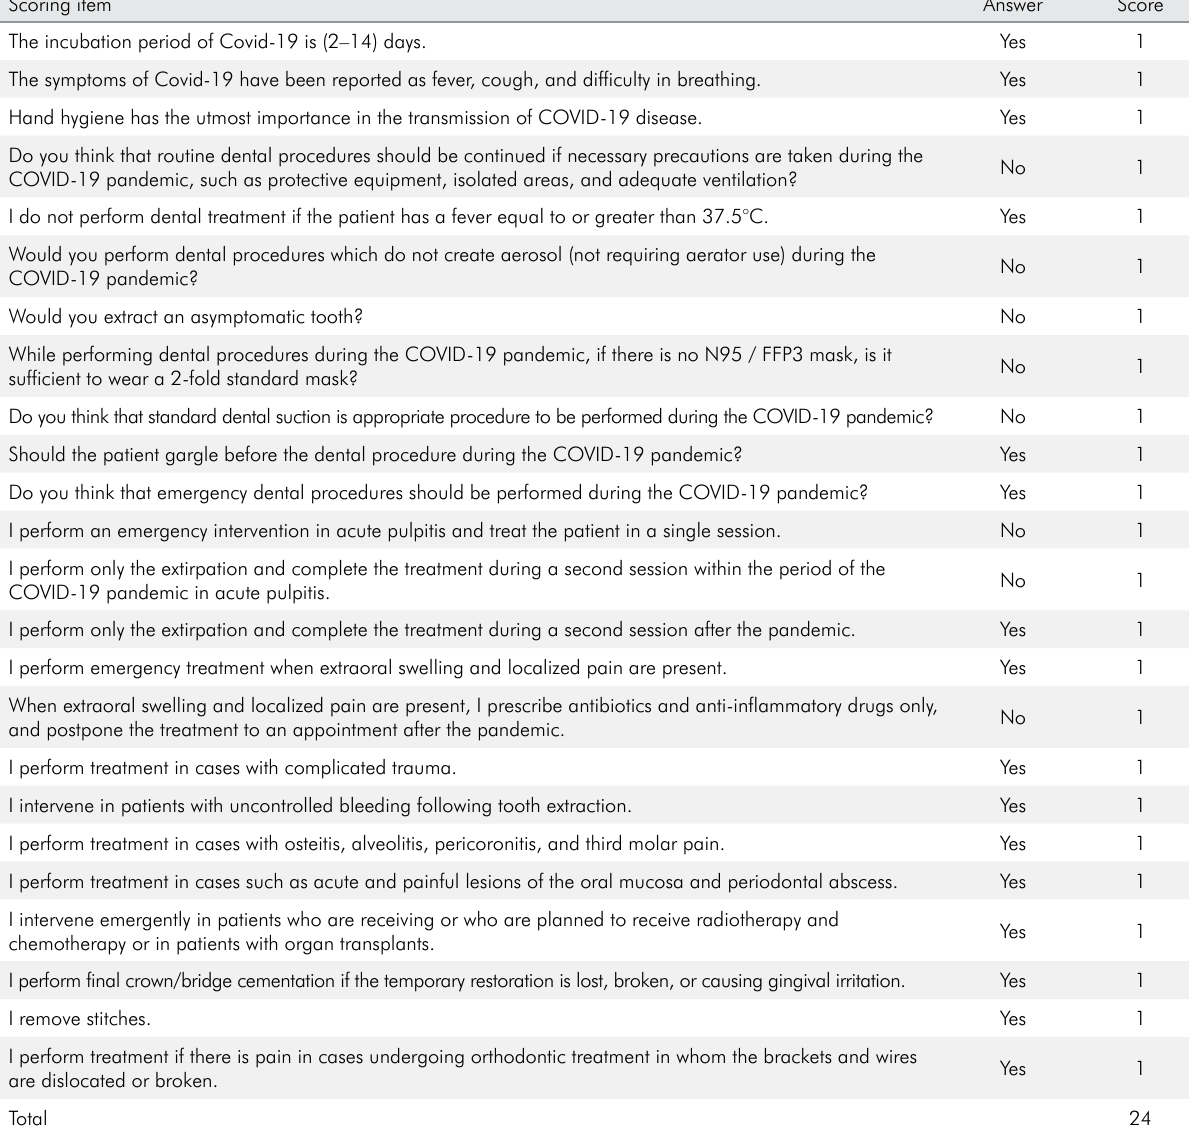
Table 1. Scoring of the knowledge level. Scoring item Answer